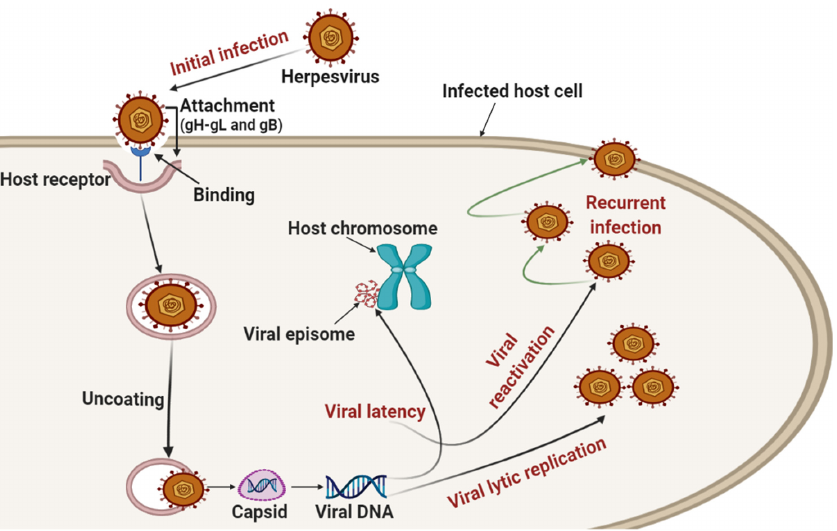
Figure 2. The basic structure of